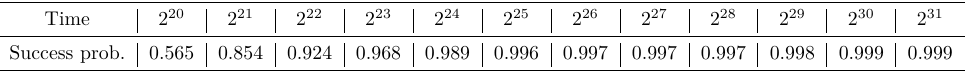
Table 1: Relationship between the time complexity and success probability for the proposed attack, where “time” denotes the number of candidates in our state-recovery attack. This result was obtained by conducting experiments with 2 20